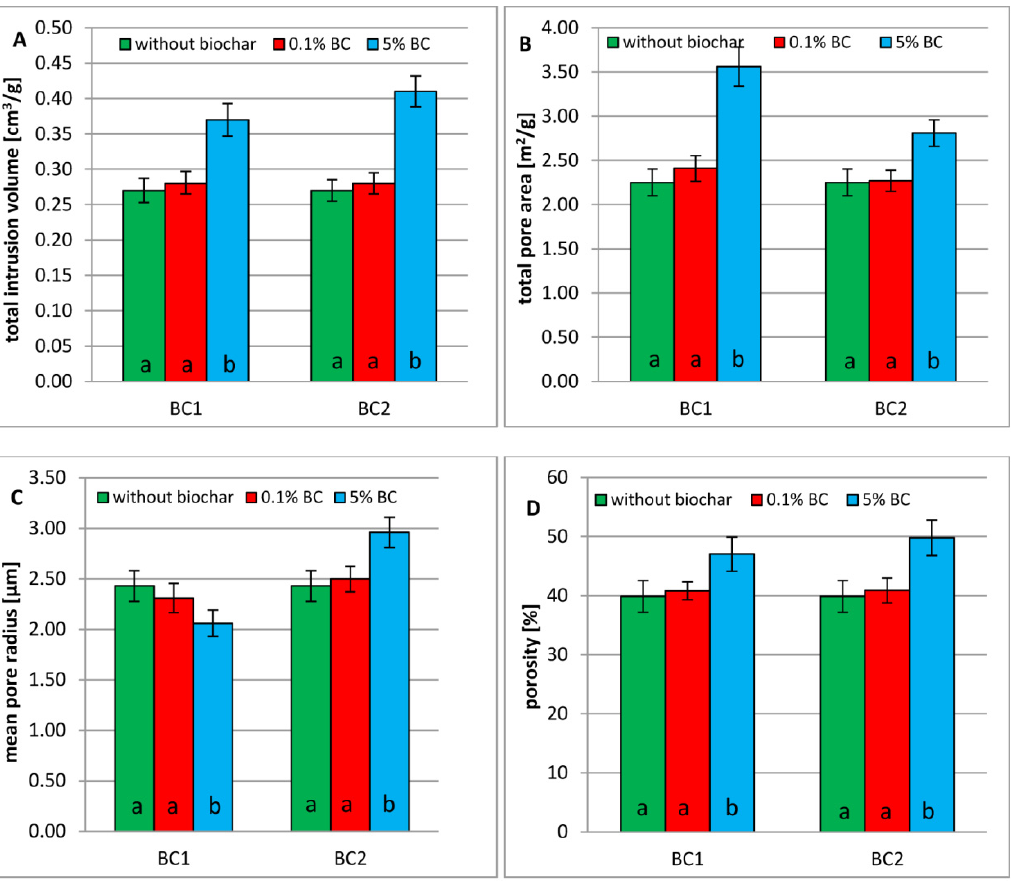
Figure 4. Porosity characteristics of the unfractionated soil cylinders with and without wood waste (BC1) and sunflower husk (BC2) biochars: ( A ) total intrusion volume, ( B ) total pore area, ( C ) average pore radius, ( D ) porosity; the bars correspond to the standard deviation.